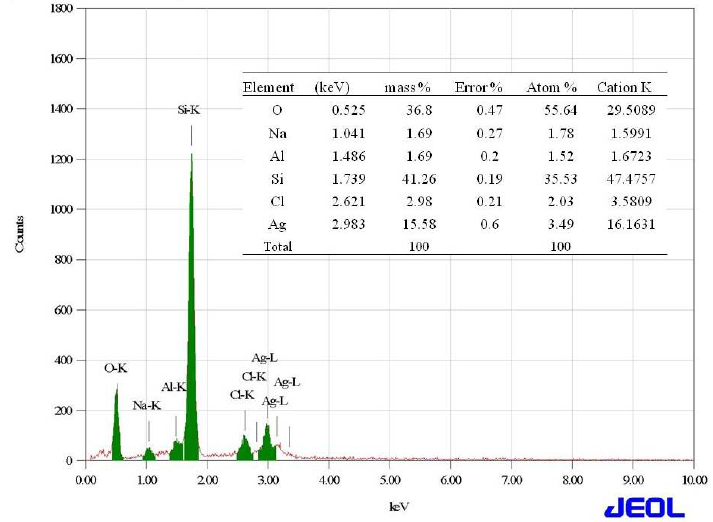
Figure 7. The Energy Dispersive Spectroscopy profile of the silver nanoparticles derived from marine Streptomyces sp. Al-Dhabi-87.